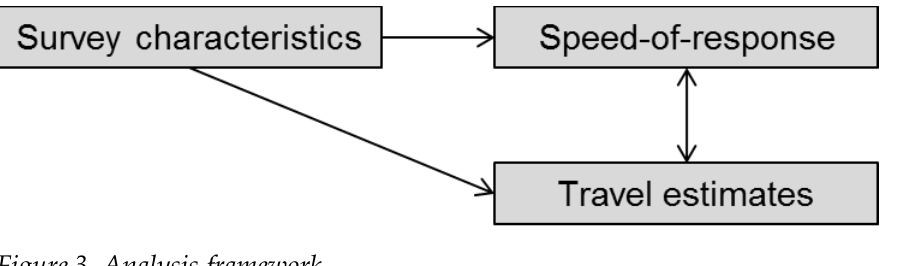
Figure 3. Analysis